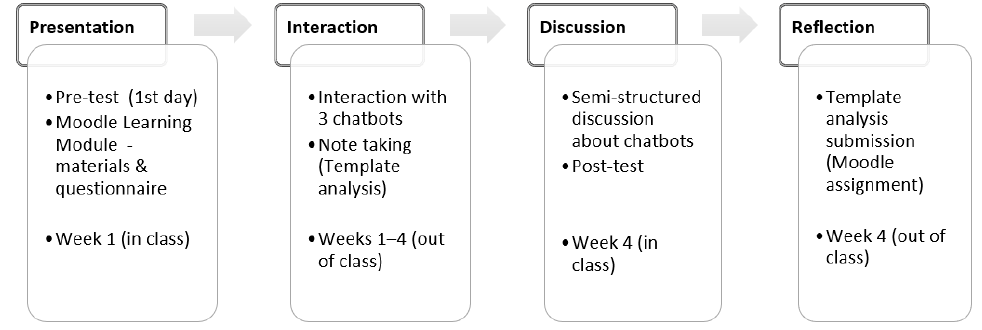
Figure 1. Research stages.